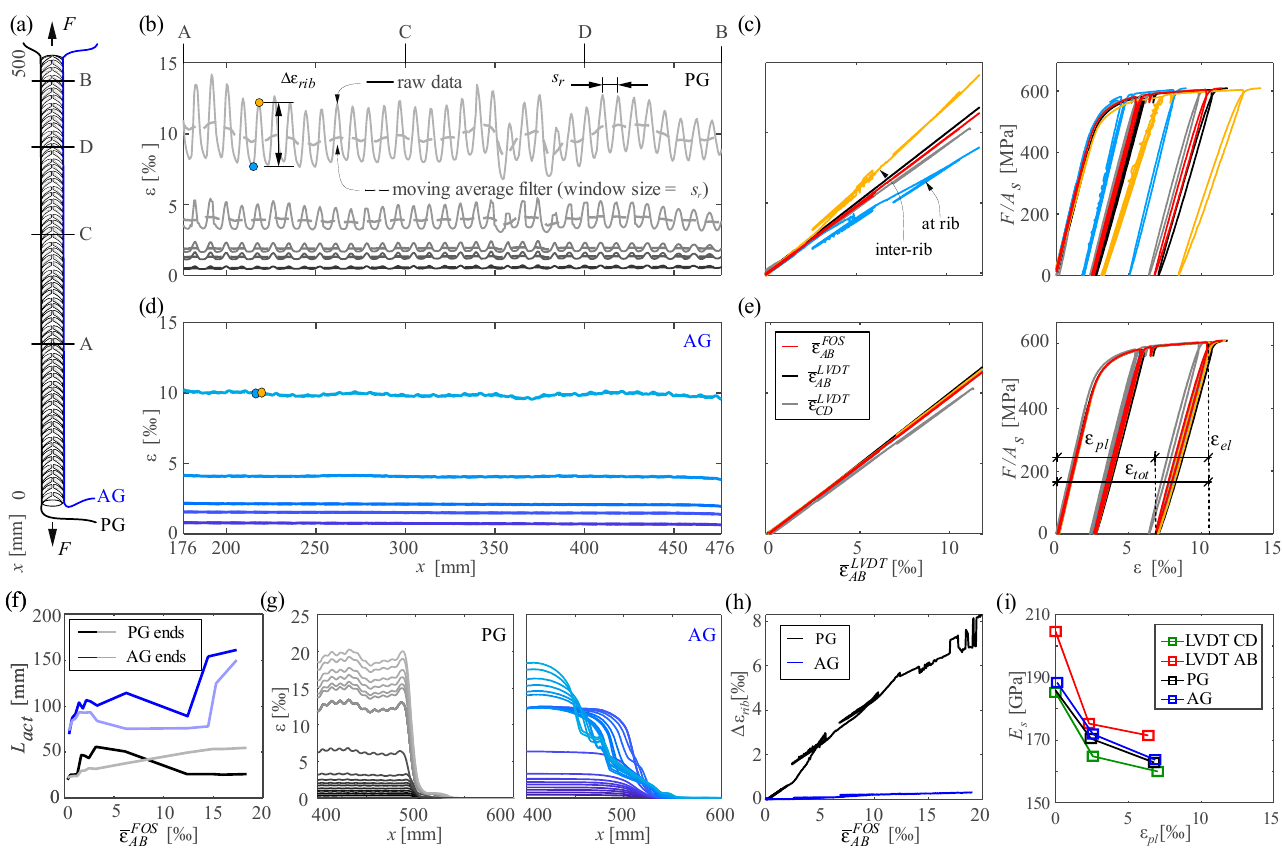
Figure 6. Cold-worked reinforcing bar cw01 tested under pure tension: ( a ) Test setup with polyimide (PG) and acrylate coated fibres (AG); ( b , d ) raw and filtered strain distributions within AB at selected load steps; ( c , e ) comparison of local strains at rib peaks and valleys with mean strains by LVDTs and DFOS, and resultant stress–strain behaviour; ( f ) activation length at both ends of PG and AG fibres; ( g ) filtered strain distributions at the right end at various load steps; ( h ) strain difference between rib valley and peak and ( i ) secant modulus as a function of plastic strains.